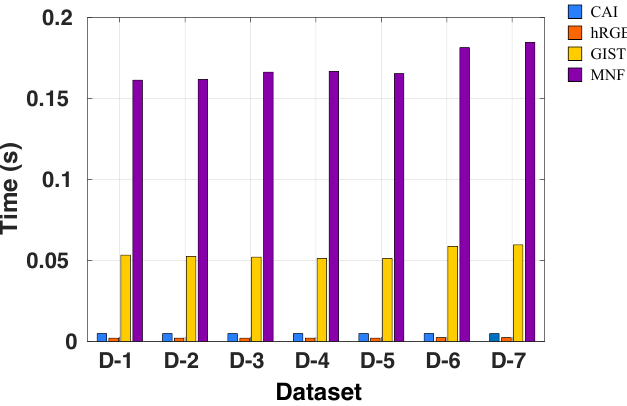
Figure 8. Average time (seconds) to generate the visual features using different descriptors on all